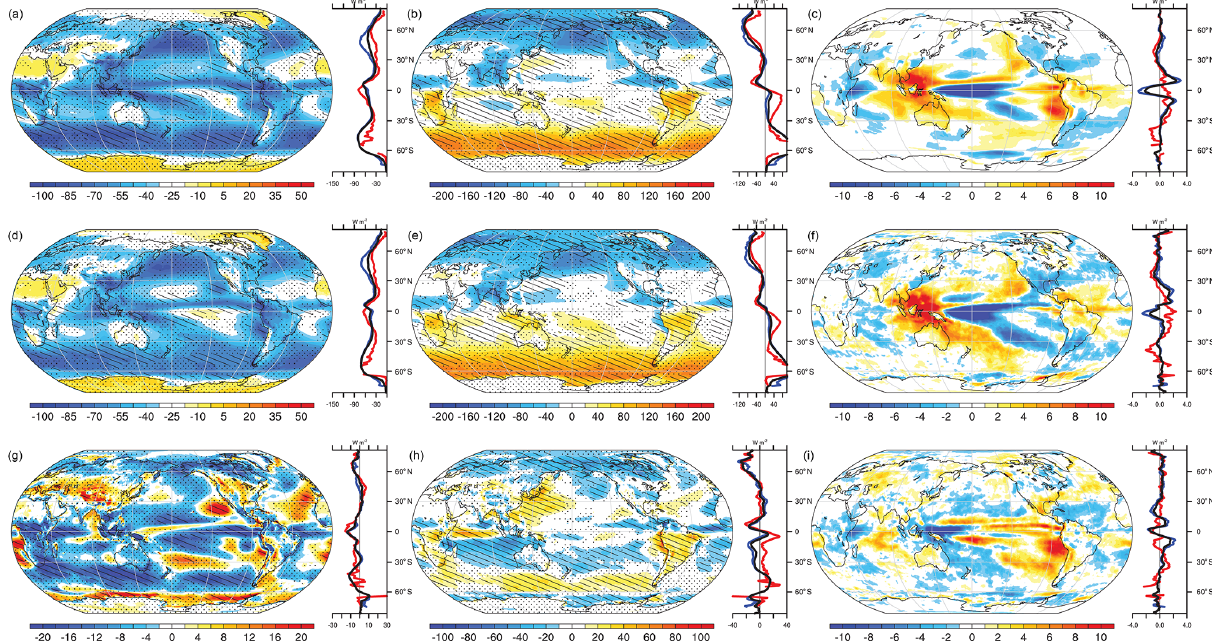
Figure 1. Mean simulated fields of SW CF in CESM2 from 1995 to 2014 for (a) the annual mean, (b) seasonal contrasts, and (c) regressed against Niño3.4 SST anomalies using July through June averages. Observed CERES EBAF4.1 estimated SW CF for 2000–2018 for (d– f) analogous metrics and (g–i) CESM2–CERES differences are also shown. Stippling indicates regions where CESM2–CERES differences exceed twice the estimated internal spread from CESM1-LE. Hatching indicates regions where differences exceed the same spread plus observational uncertainty (added in quadrature, applied to all panels in each column). Units are watts per square meter (Wm − 2 ) except for regressions (right column), where units are watts per square meter per kelvin (Wm − 2 K − 1 ). Zonal means (right panels) include land (red), ocean (blue), and global